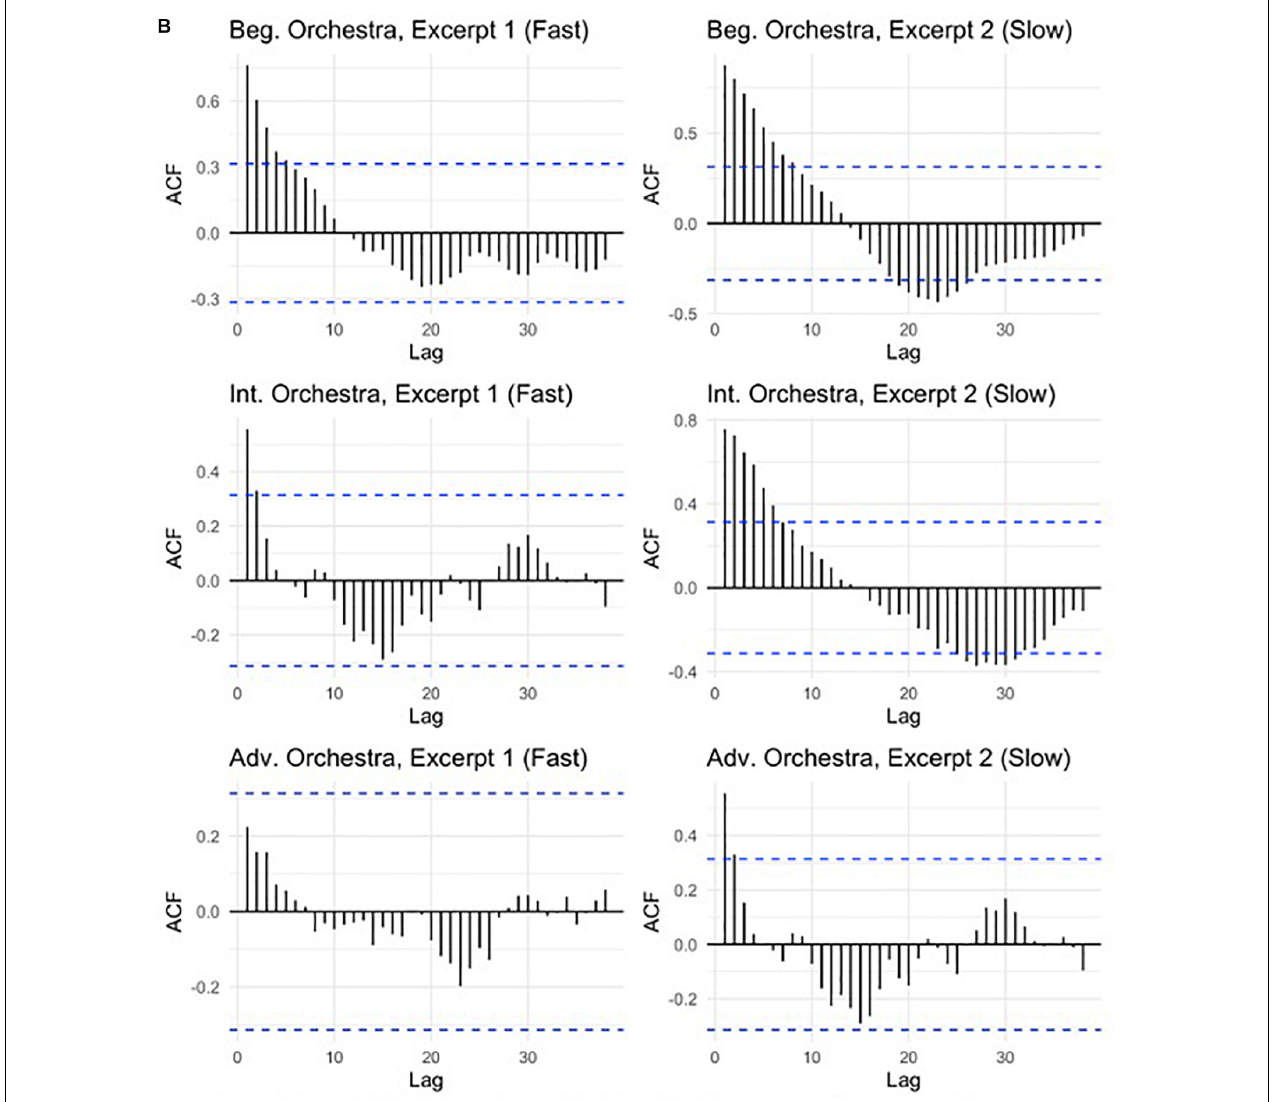
FIGURE 6 | (A) Wind band autocorrelations of mean time series by excerpt and experience. (B) Orchestra autocorrelations of mean times series by excerpt and experience. Autocorrelation function (ACF) values indicate the correlation of mean conductor-ensemble offset instances with lagged values across a time series. A cyclical departure-and-return pattern can be seen in many examples, indicating that the quantities of offset correlate over time. This suggests a progression or seasonality to changes in those values over the course of a given